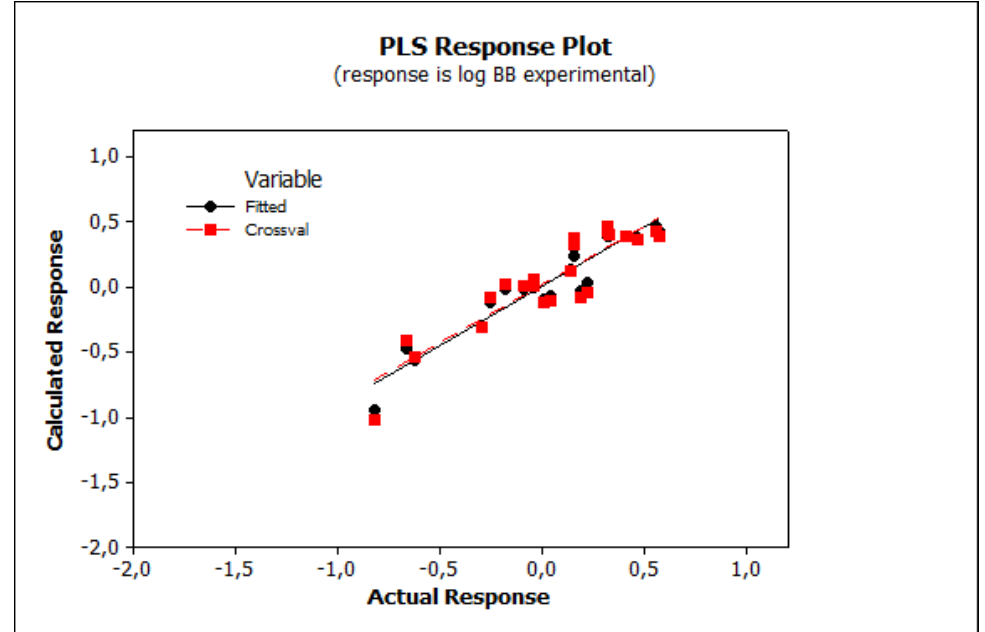
Figure 2. PLS response plot (Equation (10)).